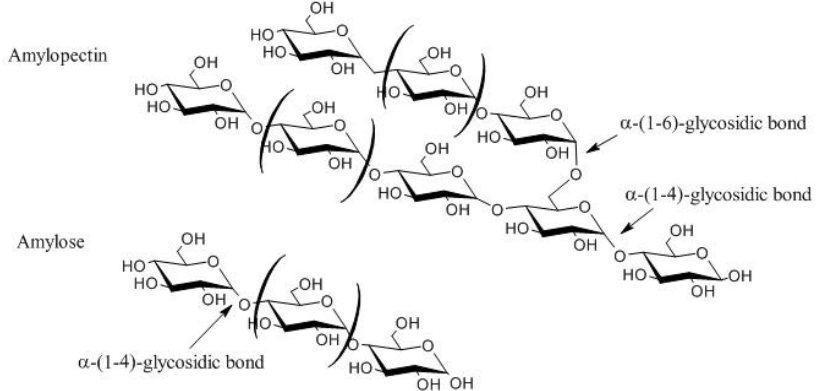
Figure 1. Representation of the starch structure of amylose and amylopectin. Similarly, to amylose and amylopectin, starch is a semi-crystalline polymer with linear regions; however, the α (1–6) branches of amylopectin reduce the degree of organization of the polymer [24,25]. Amylopectin consists of a short chain of 10–60 units of